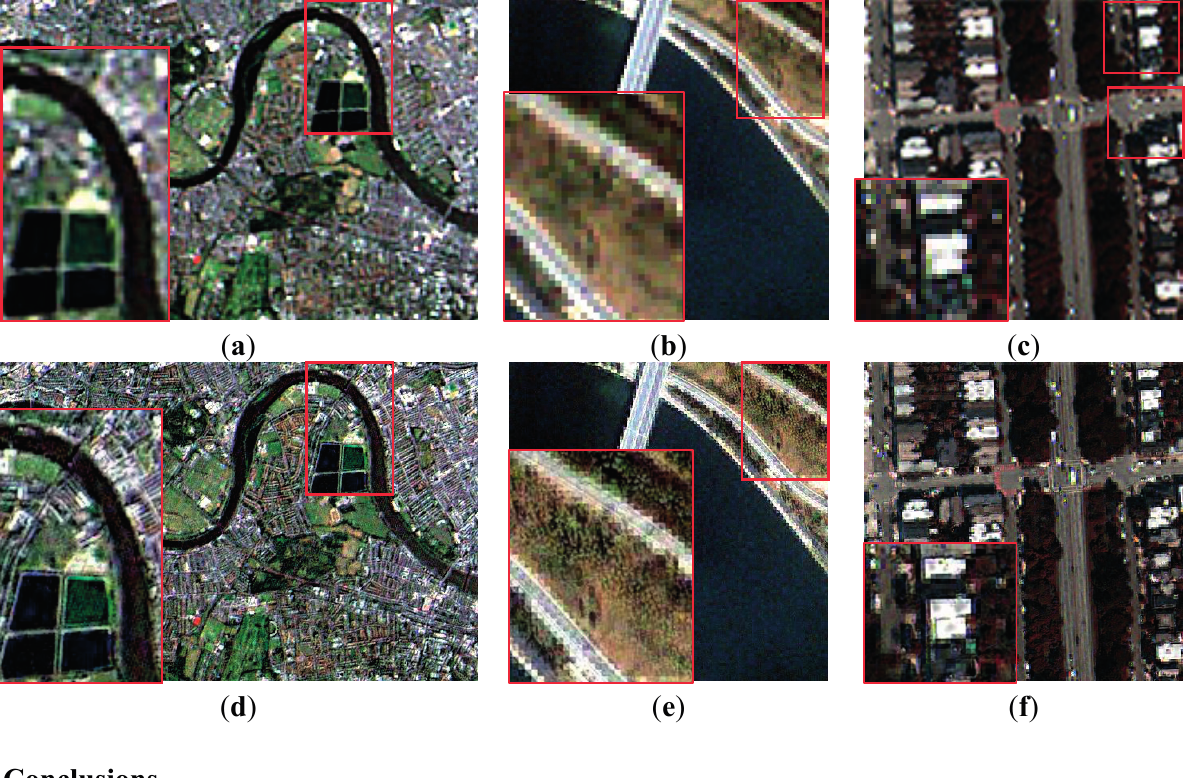
Figure 16. ( a ) Original TM multispectral image. ( b ) Original IKONOS multispectral image. ( c ) Original WorldView-II multispectral image. ( d ) BEMD fusion image. ( e ) BEMD fusion image. ( f ) BEMD fusion